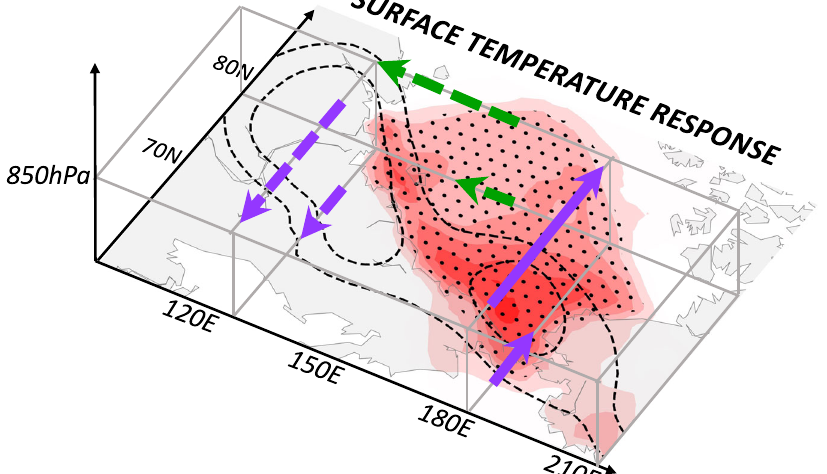
Fig. 8 The mechanisms associated with sea ice loss. A schematic of the wind response at the surface (short arrows) and 850 hPa (long arrows) in colors and styles shown in Fig. 7c, f, along with the CNTL 850-hPa geopotential height anomaly as line contours (given at − 23 m and − 20 m; same as fi lled contours in Fig. 6a) and surface temperature response as fi lled contours (every 1 K interval).